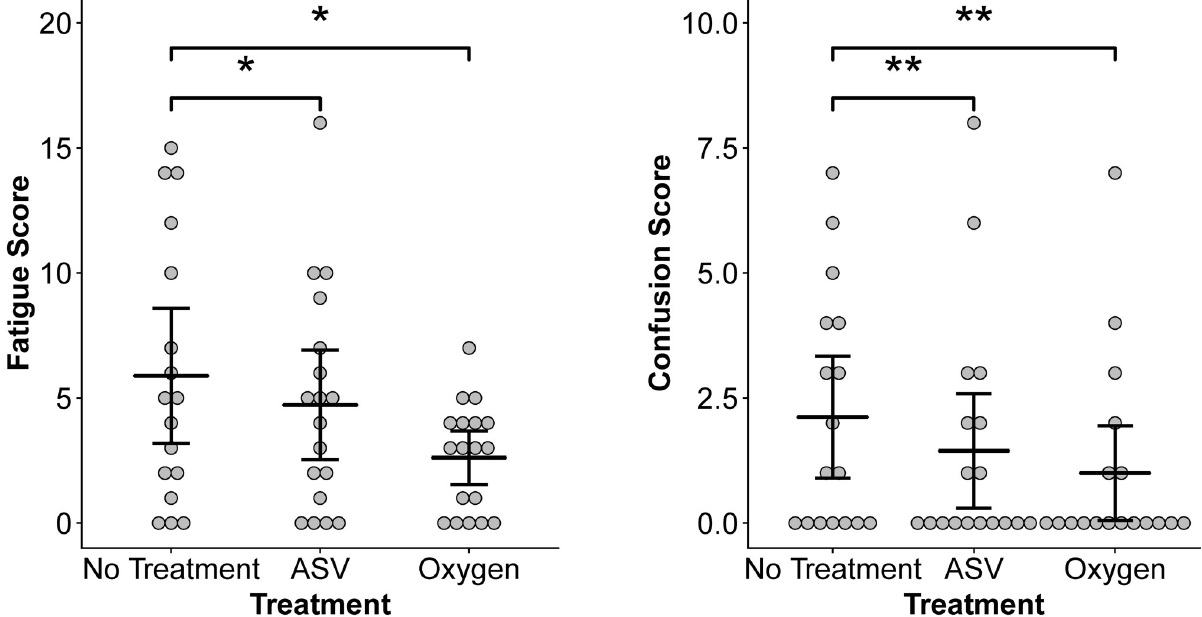
Fig 2. ASV and supplemental oxygen sleep treatments decrease fatigue and confusion. Results of post-hoc Tukey HSD tests on two-way ANOVA tests examining independent effects of sleep treatment on fatigue and confusion within subjects. Means and 95% confidence intervals for each treatment group are provided. Asterisks indicate significance at p < 0.05 ( � ) and p < 0.01 ( ��